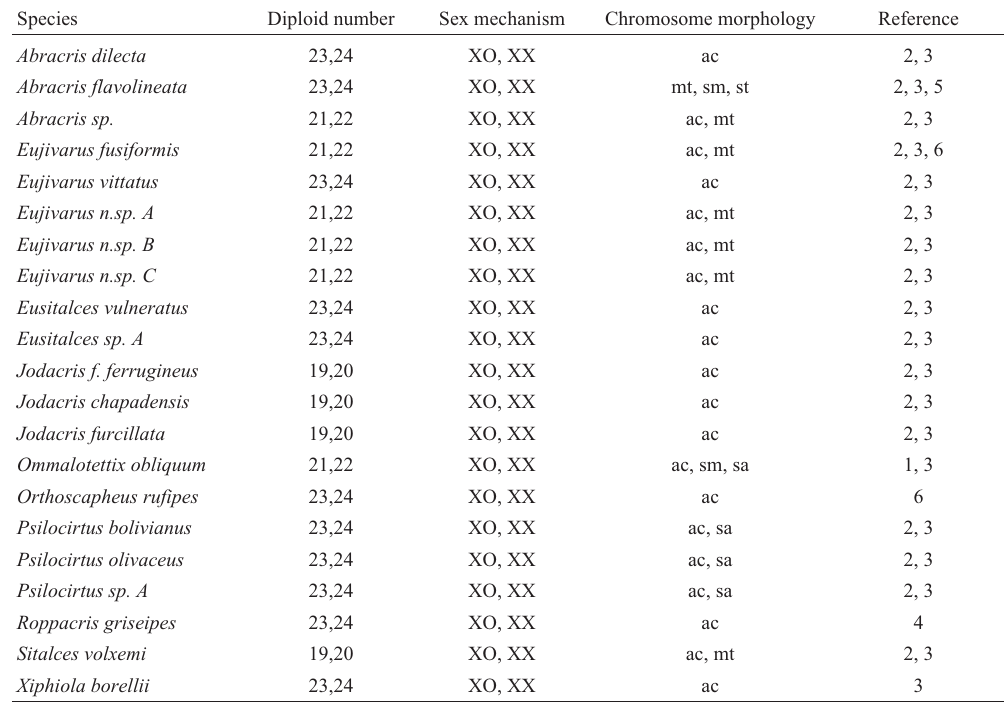
Table 2 - Chromosome number, sex mechanism and chromosome morphology in representatives of the tribe Abracrini (Ommatolampinae-Acrididae).